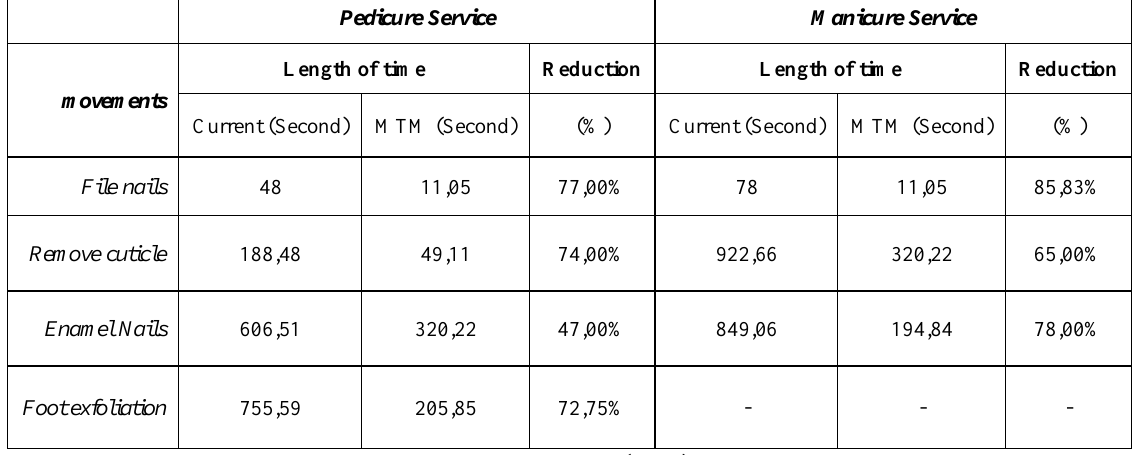
Table 3: MTM analysis of pedicure and manicure